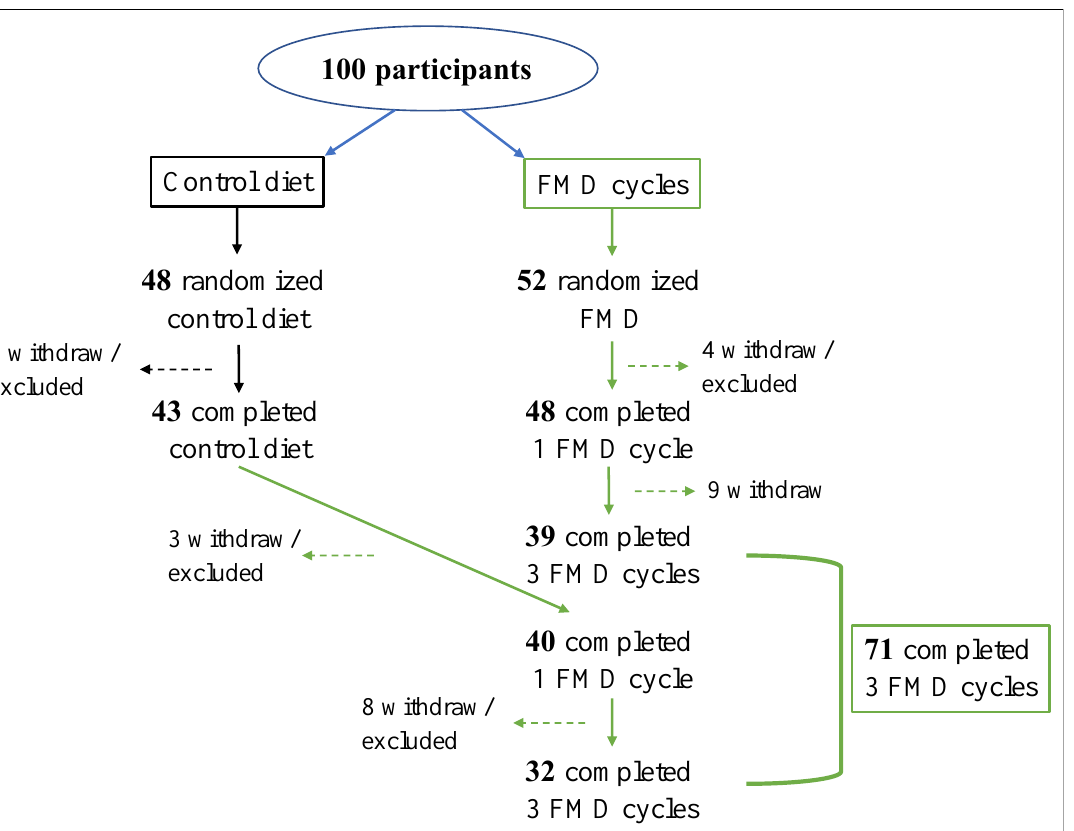
Figure 2. CONSORT diagram. CONSORT diagram of participants selected for the clinical study described by Brandhorst et al., and Wei et al. [112,140] . In the clinical study, 100 participants were enrolled; 48 subjects were randomized to a control group and were asked to continue their normal diet for 3 months and then were subjected to 3 FMD cycles (16 participants withdrew or were excluded throughout the study). Instead, 52 subjects were randomized to the FMD group; FMD was provided for 5 consecutive days per month, for 3 months (13 subjects withdrew or were excluded throughout the study). [112,140] .